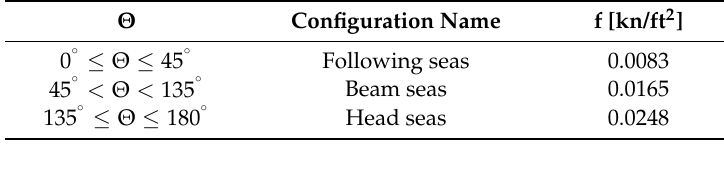
Table 1. Values of the coefficient f.